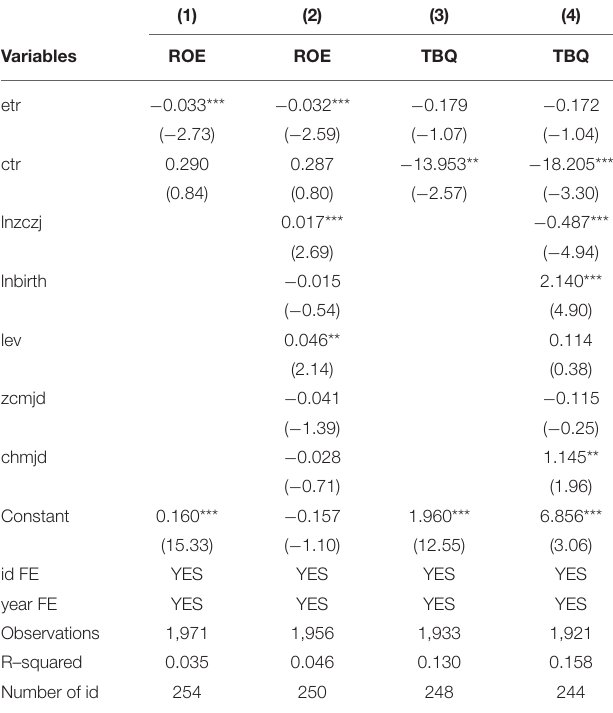
TABLE 5 | Principal regression result. TABLE 6 | Results of heterogeneous regression of short–term financial